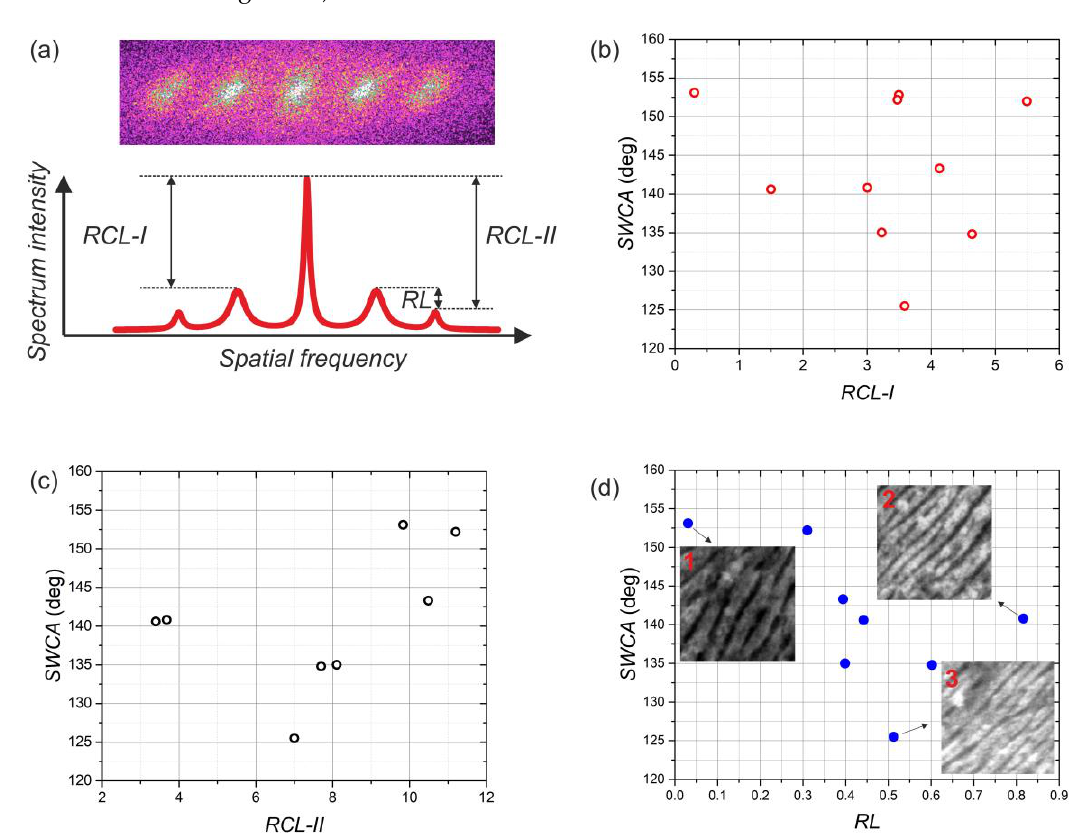
Figure 6. ( a ) Evaluation of the ratios between LSFL-I peak height and central peak height (RCL-I), between LSFL-II peak height and central peak height (RCL-II), and between the LSFL-I and LSFL-II (RL) in the Fourier space. ( b ) Dependence of SWCA on the ratio between LSFL-I peaks and central peak in the Fourier space (RCL-I). ( c ) Dependence of SWCA on the ratio between LSFL-II peaks and central peak in the Fourier space (RCL-II). ( d ) Dependence of SWCA on the ratio between LSFL-I and LSFL-II peaks (RL). Samples were fabricated using the same fluence (0.041 J/cm 2 ) and variable hatch distance.